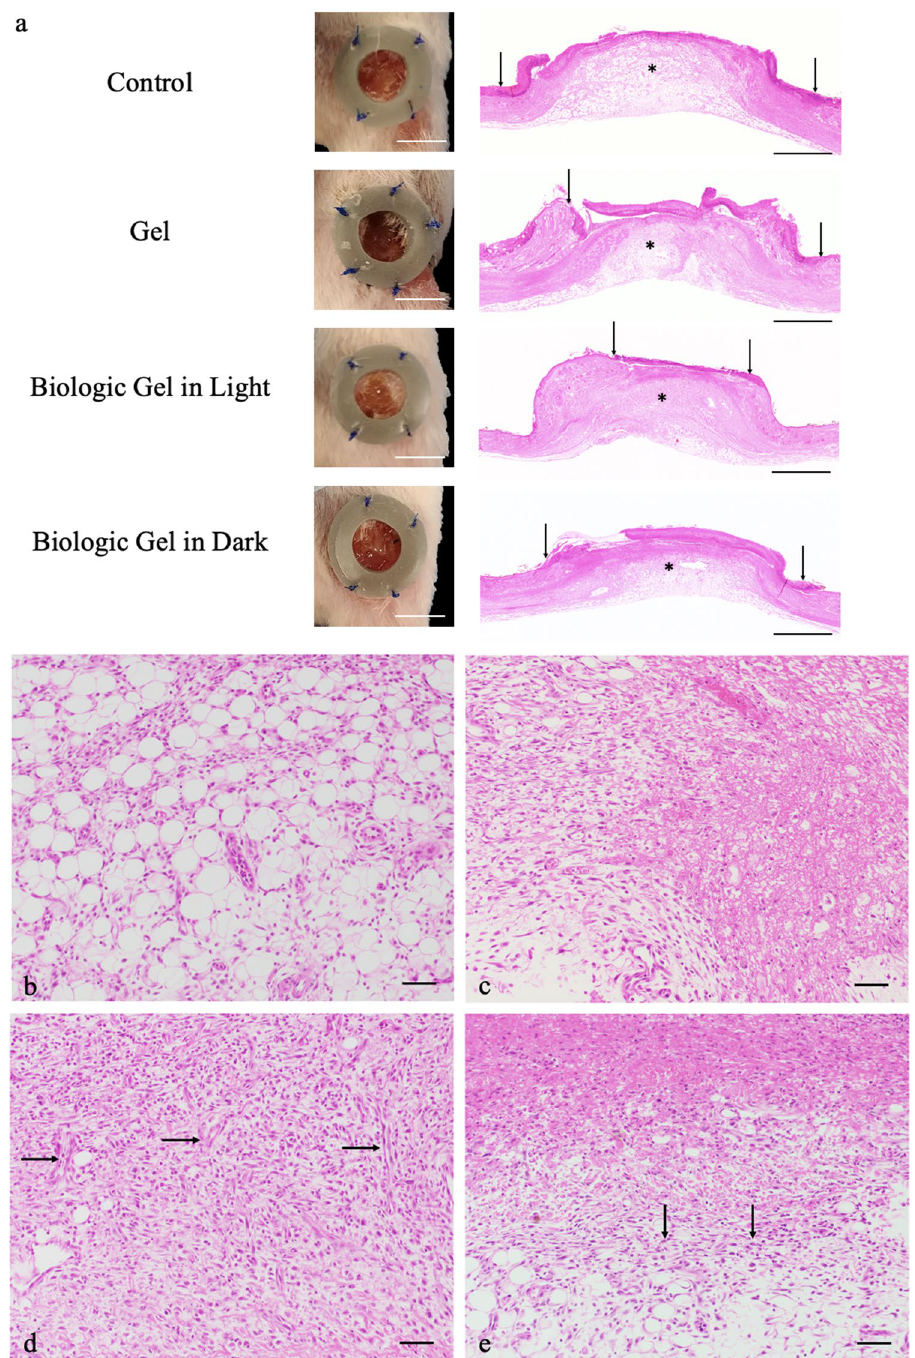
Figure 5. Gross and histopathological evaluation of distal thigh wounds after 3 days of treatment in a rodent peripheral arterial disease ischemic wound model. ( a ) Gross distal thigh lesions after 3 days of daily treatment showed smaller wound area in the wound that received the novel biologic gel treatment in light compared to the wounds that received other treatment. Scale bar = 5 mm. Hematoxylin and eosin stain of longitudinal sections of the distal thigh lesions 3 days after acute ischemic injury showed that wounds that were treated with biologic gel in light generally had increased amounts of dermal and subcutaneous granulation tissue formation (asterisk) compared to those receiving other treatments. Re-epithelialization margins were also generally more central within the wound bed in the wound treated with biologic gel in light compared to those that received other treatments. Vertical arrows denote margins of re-epithelialization. Scale bar = 1 mm. ( b – e ) Hematoxylin and eosin stain of cross sections of the distal thigh lesions under higher magnification showed that wounds that were treated with biologic gel in light ( d ) had increased amounts of granulation tissues as evidenced by new blood vessels (horizontal arrows) perpendicularly oriented to fibroblasts and collagen fibers. Granulation tissue was less frequent in controls ( b , not present), animals treated with gel only ( c , no present), or animals treated with biologic gel in dark ( e , vertical arrows). The control group received no treatment. Scale bar = 50